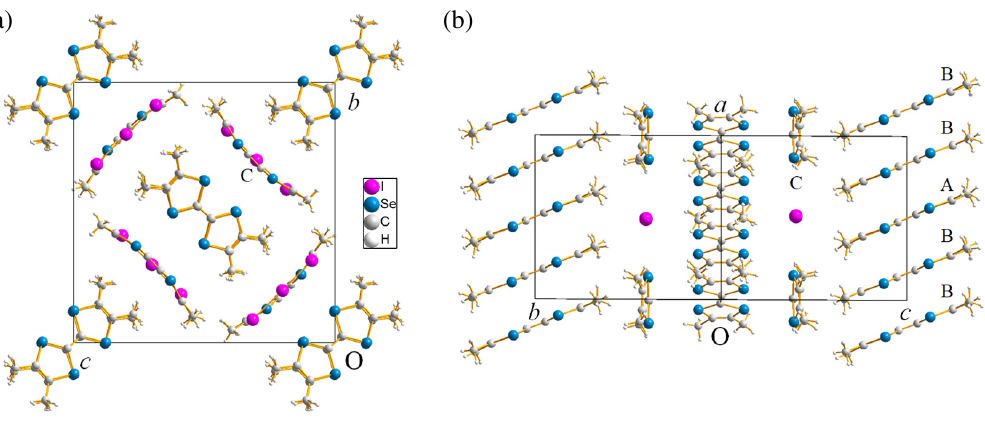
Figure 5. The crystal structure of (TMTSF) 5 (I 3 ) 2 at room temperature viewed along ( a ) the a -axis and ( b ) the ( b + c )-direction, respectively. The crystallographically independent TMTSF molecules are labeled A, B, and C.